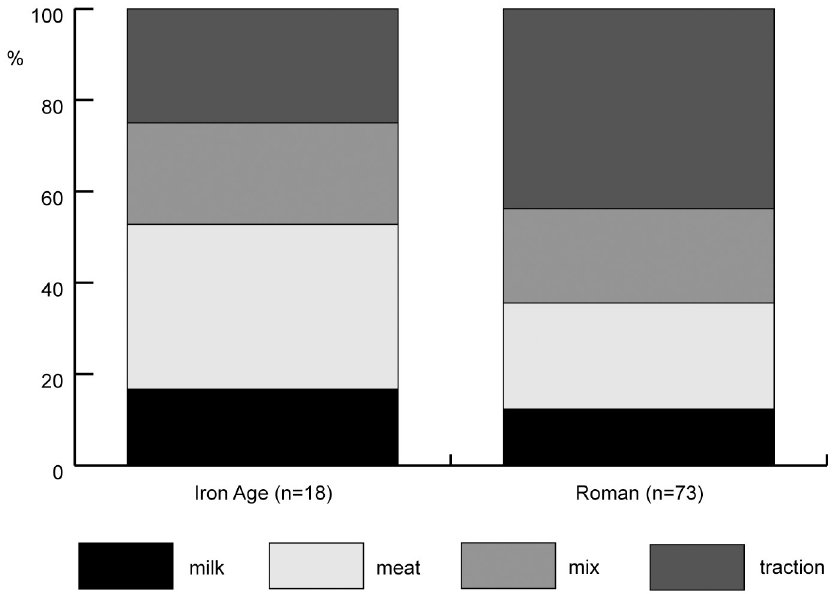
Fig 2. Percentages of assemblages per type of cattle exploitation for the Iron Age and Roman Netherlands (all regions and types of site combined). n = number of sites for which the type of exploitation could be established. Mortality profiles based on tooth eruption and wear and epiphyseal fusion were analysed to establish the type of exploitation.